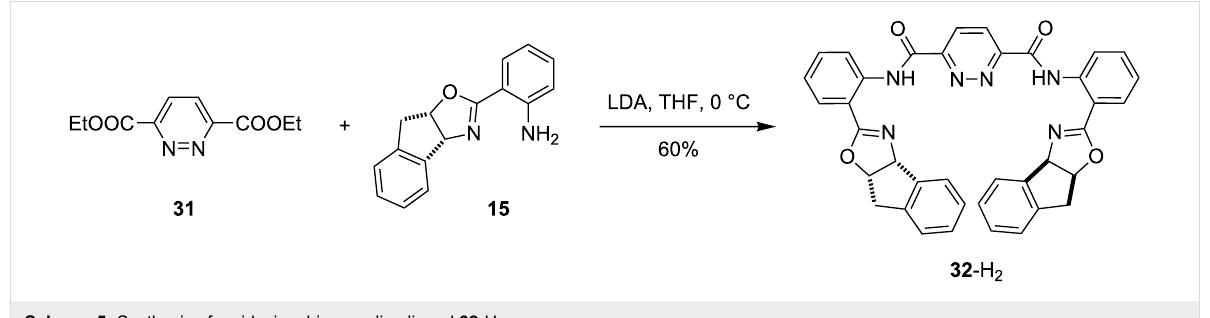
Scheme 5: Synthesis of pyridazine–bisoxazoline ligand 32 -H 2 .